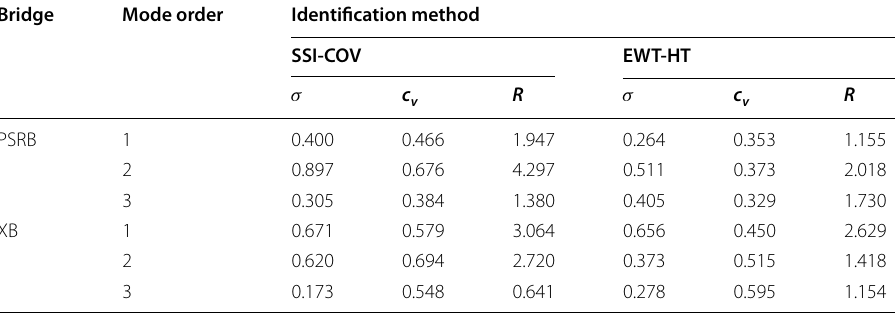
Table 3 Statistics of dispersion indexes of identified modal damping ratios of PSRB and XB